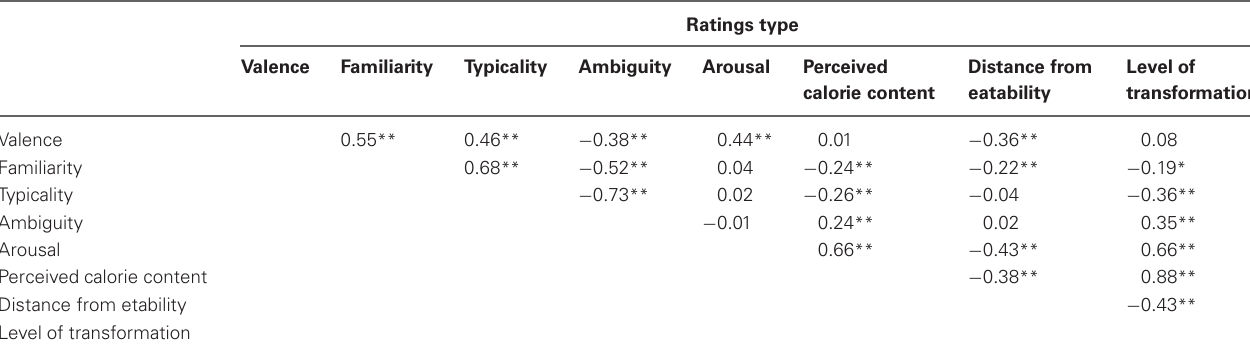
Table 2 | Correlation between validation dimensions for food (natural-food and transformed food, N =